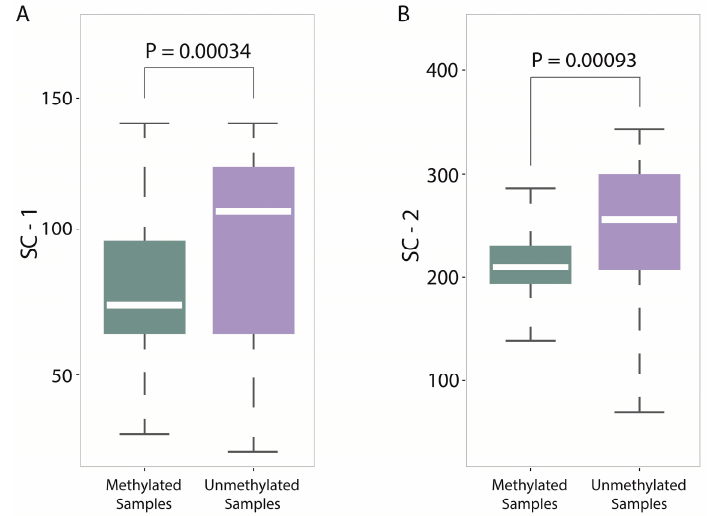
Figure 5. Distribution differences between methylated samples and unmethylated samples on two SC features: ( A ) box-plots of the distributions of methylated samples and unmethylated samples on SC-1 feature and corresponding statistical test ( p -value = 0.00034); and ( B ) box-plots of the distributions of methylated samples and unmethylated samples on SC-2 feature and corresponding statistical test ( p -value = 0.00093).